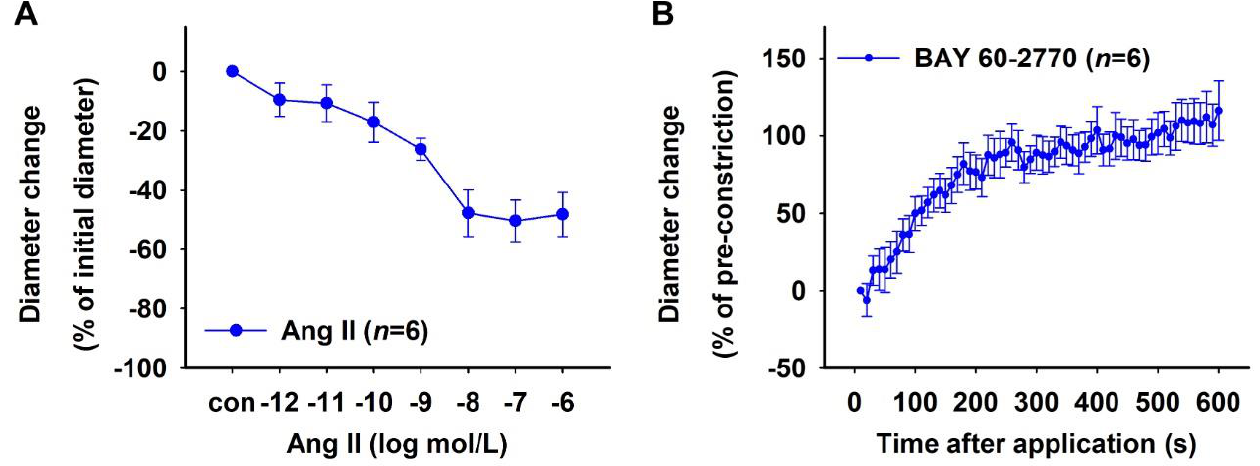
Figure 4. sGC activation in human DVR. ( A ) Concentration–response curve showing constriction induced by 10 −12 – 10 −6 mol/L Ang II. Vessel diameters did not change in the absence of Ang II (con). ( B ) Time–response curve showing relaxation induced by 10 − 6 mol/L BAY 60-2770. Vessels were pre-constricted with 10 − 6 mol/L Ang II. BAY 60-2770 caused an almost instantaneous relaxation of the vessels with maximum relaxation achieved in 3 min.